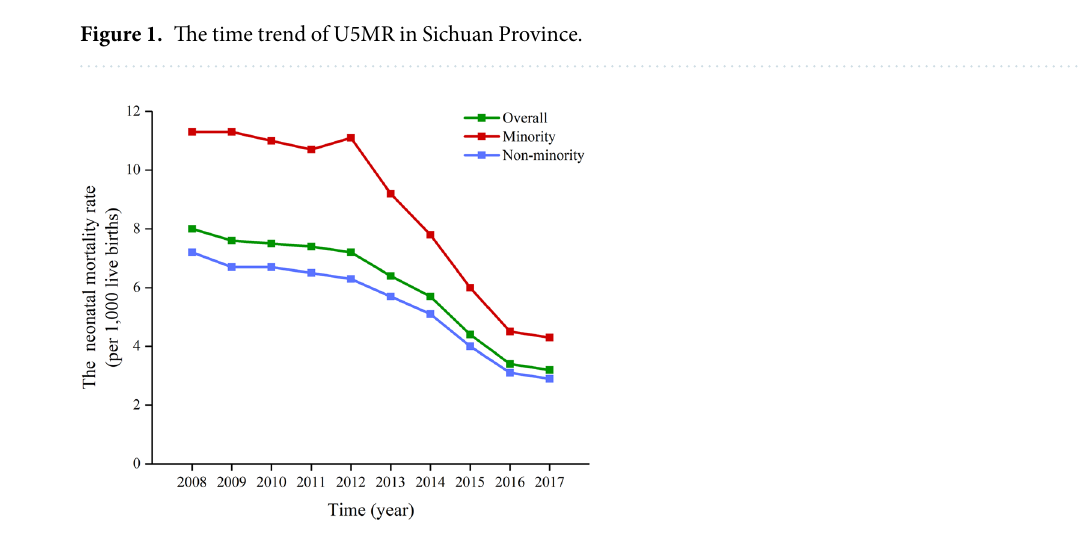
Figure 2. The time trend of NMR in Sichuan